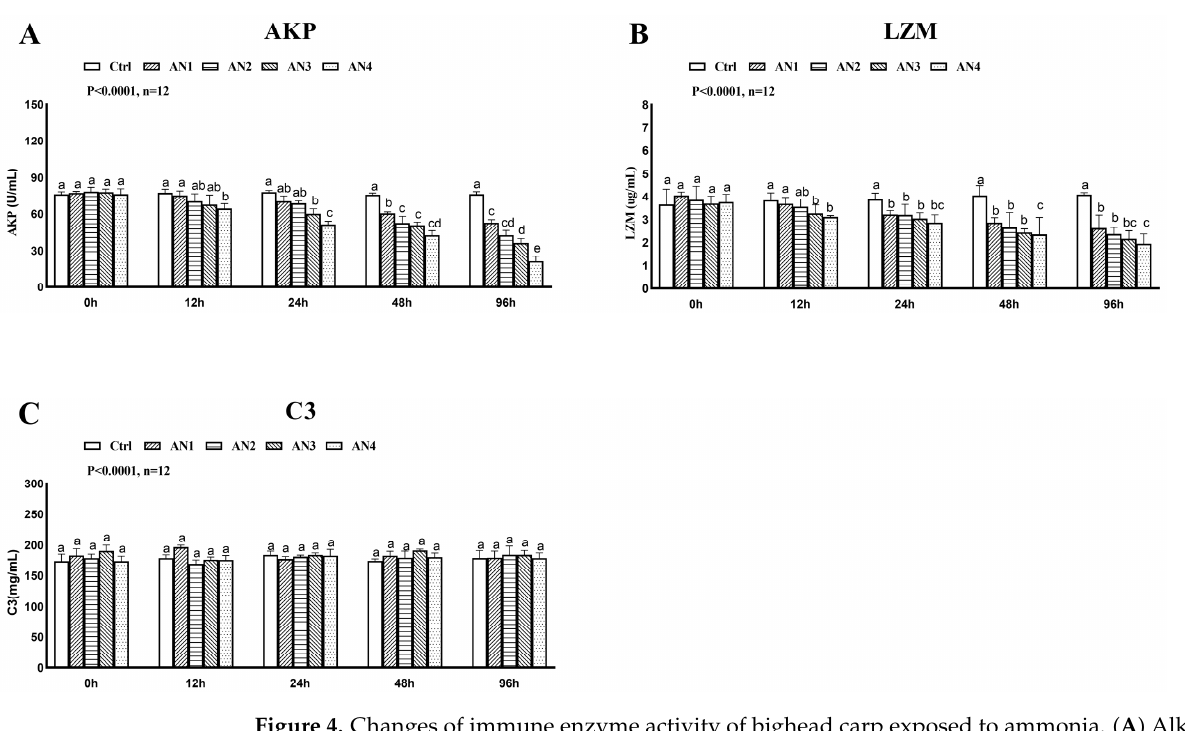
Figure 4. Changes of immune enzyme activity of bighead carp exposed to ammonia. ( A ) Alkaline phosphatase (AKP), ( B ) lysozyme (LZM), ( C ) complement 3 (C3). Values are expressed as mean ± standard error (SE) from triplicate groups ( n = 12). Bars with different letters (a, b, c, d, e) differ significantly from those of other groups ( p < 0.05).